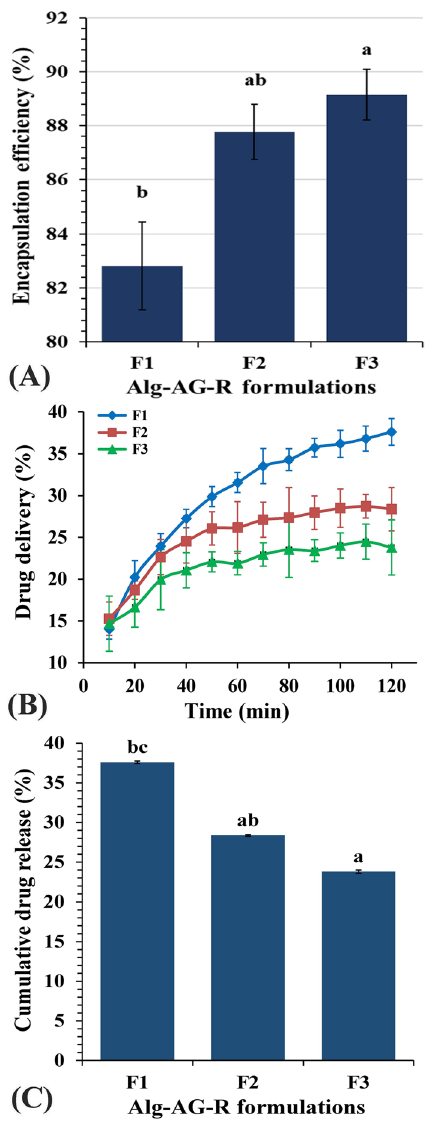
Figure 7. ( A ) Encapsulation efficiency of riboflavin alginate-Arabic gum formulations, ( B ) In vitro riboflavin release from riboflavin entrapped Alg-AG beads, ( C ) Cumulative drug release